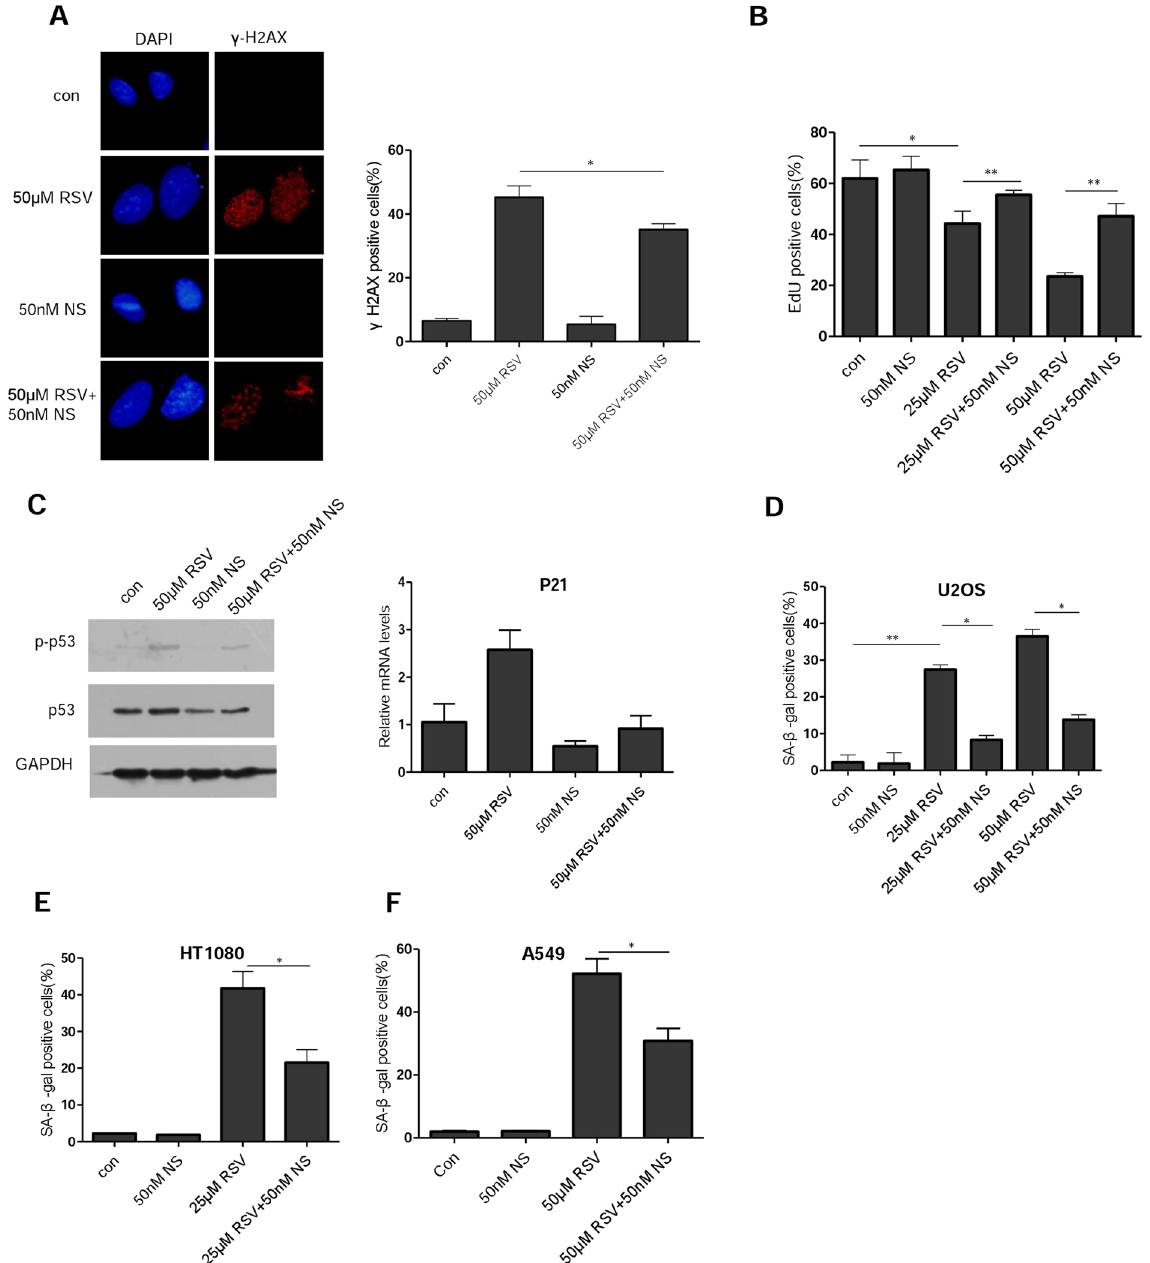
Figure 2. Resveratrol-induced cellular senescence can be attenuated by nucleosides. ( A ) Immunofluorescence staining of γ -H2AX in U2OS cells. Cells growing on coverslips in 6-well plates were exposed to RSV (50 μ M) alone or in combination with nucleosides (50 nM) for 24 h, and fixed for examination by immunofluorescence. ( B ) EdU proliferation assay was performed in U2OS cells 48 h after treatment with RSV alone or in combination with nucleosides, the percentages of EdU positive cells are shown as the mean ± S.D. from three independent experiments. ( C ) Left, U2OS cells were exposed to RSV with or without nucleosides for 48 h. Whole cell lysates were analyzed by immunoblotting with antibodies specific for p-p53 and p53, respectively. GAPDH was used as a loading control. Right, with the same treatment as in the left, but examined for expression of p21 mRNA levels by RT-PCR. ( D ) U2OS cells were incubated with RSV with or without addition of the indicated concentration of nucleosides (NS). On day 7, cells were examined for SA- β -gal activity. Mean of three independent experiments with SEM is shown. ( E , F ) The same as in ( D ) but in HT1080 and A549 cells, respectively. * P < 0.05, ** P < p53-mediated CXCR2 upregulation contributes to cellular senescence. RSV-induced senescence requires the activation of p53 12 . We previously showed that the upregulation of p53-CXCR2 axis plays a key role in stress-induced senescence in normal human fibroblasts and U2OS cells 35 . Indeed, CXCR2 transcription was significantly increased by RSV in a dose- and time-dependent manner (Fig. 5A). The increased expression of